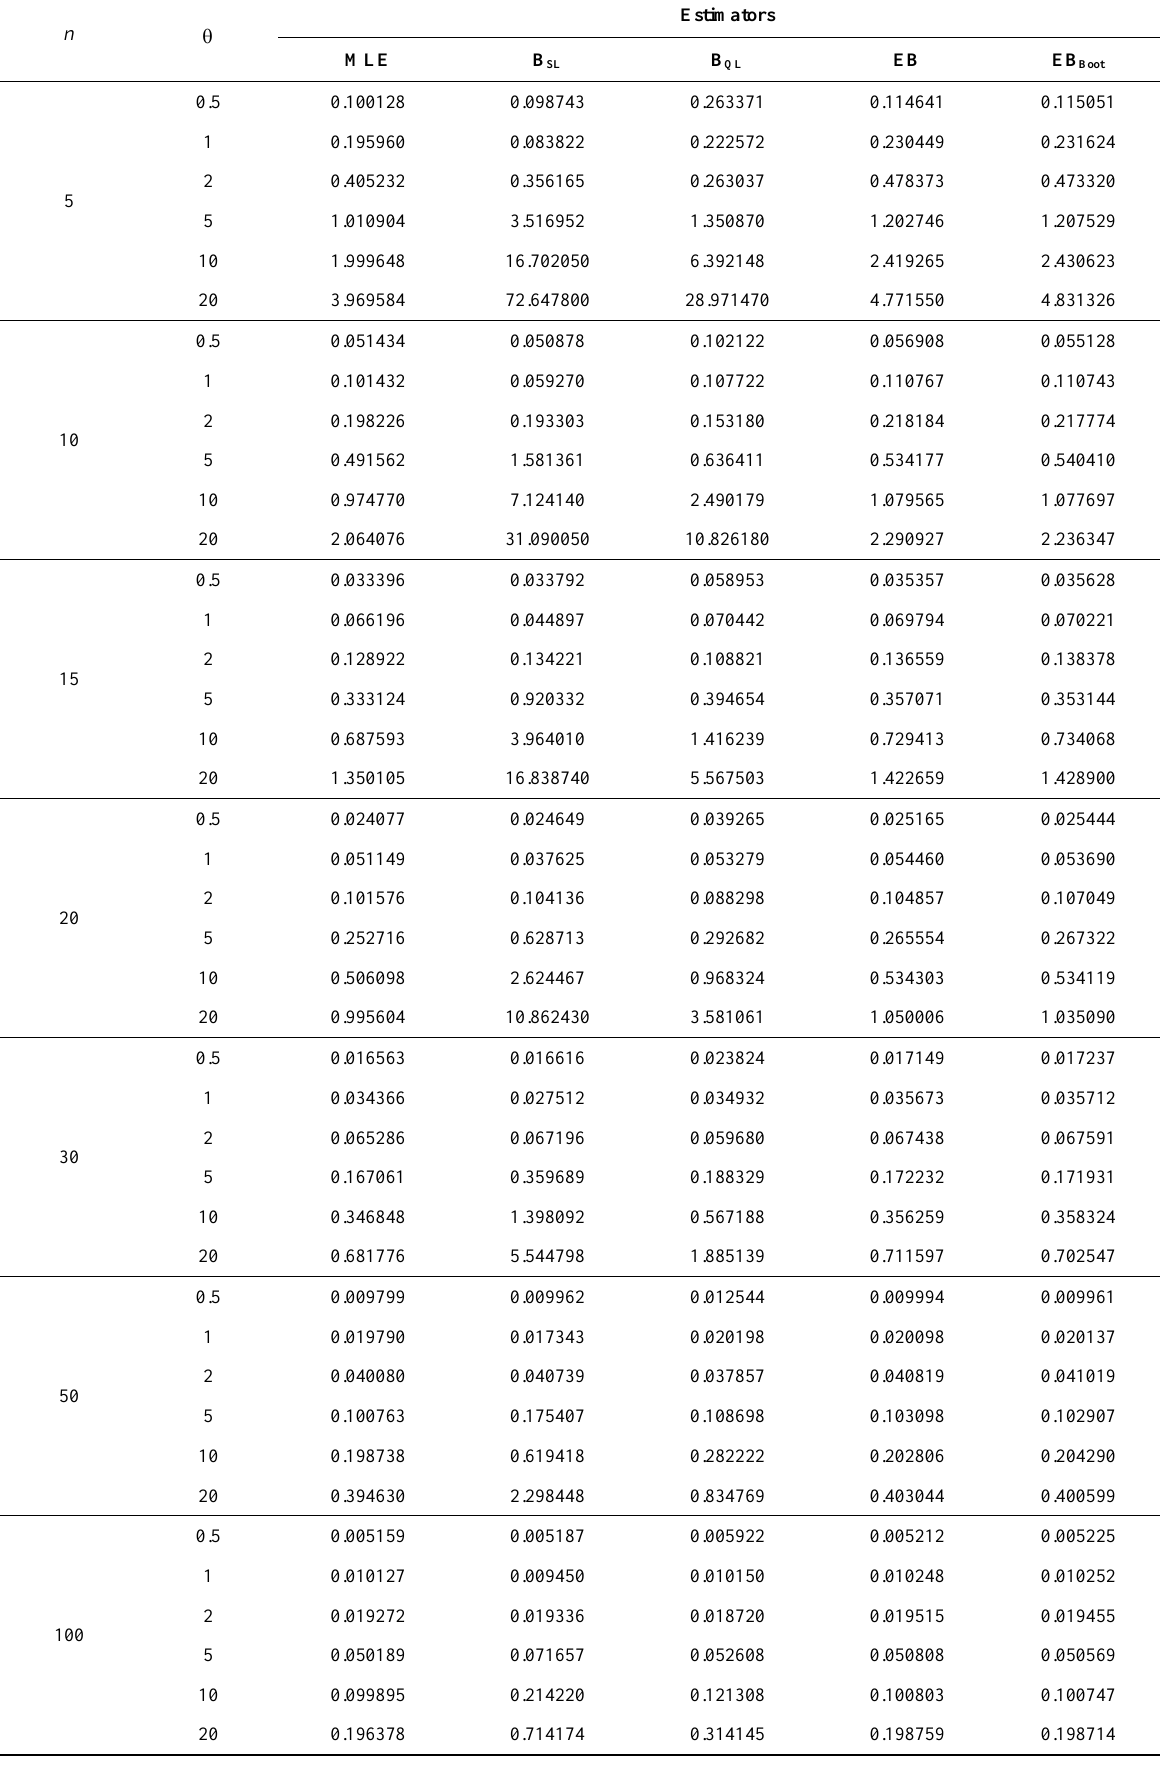
Table 4. MSE of different estimators of Poisson distribution when a =4, b